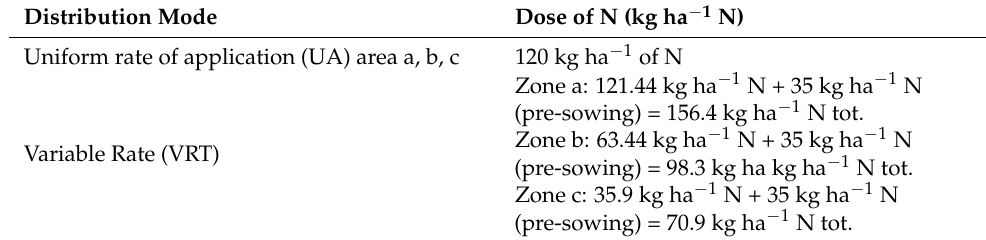
Table 1. Nitrogen management of site 1.